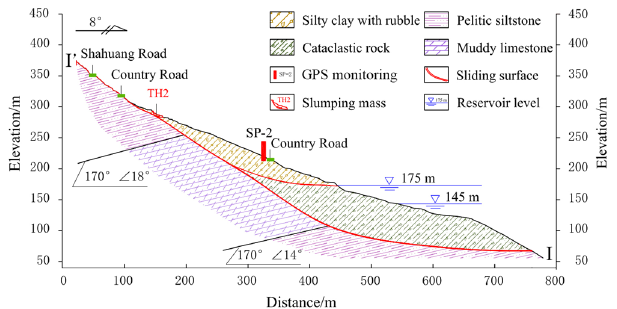
Figure 3. Schematic geological cross-section (I-I’) of the Shuping landslide (Drawn by Ying Cao using AutoCAD 2014, https://www.autodesk.com.cn/), the track can be seen in Fig.